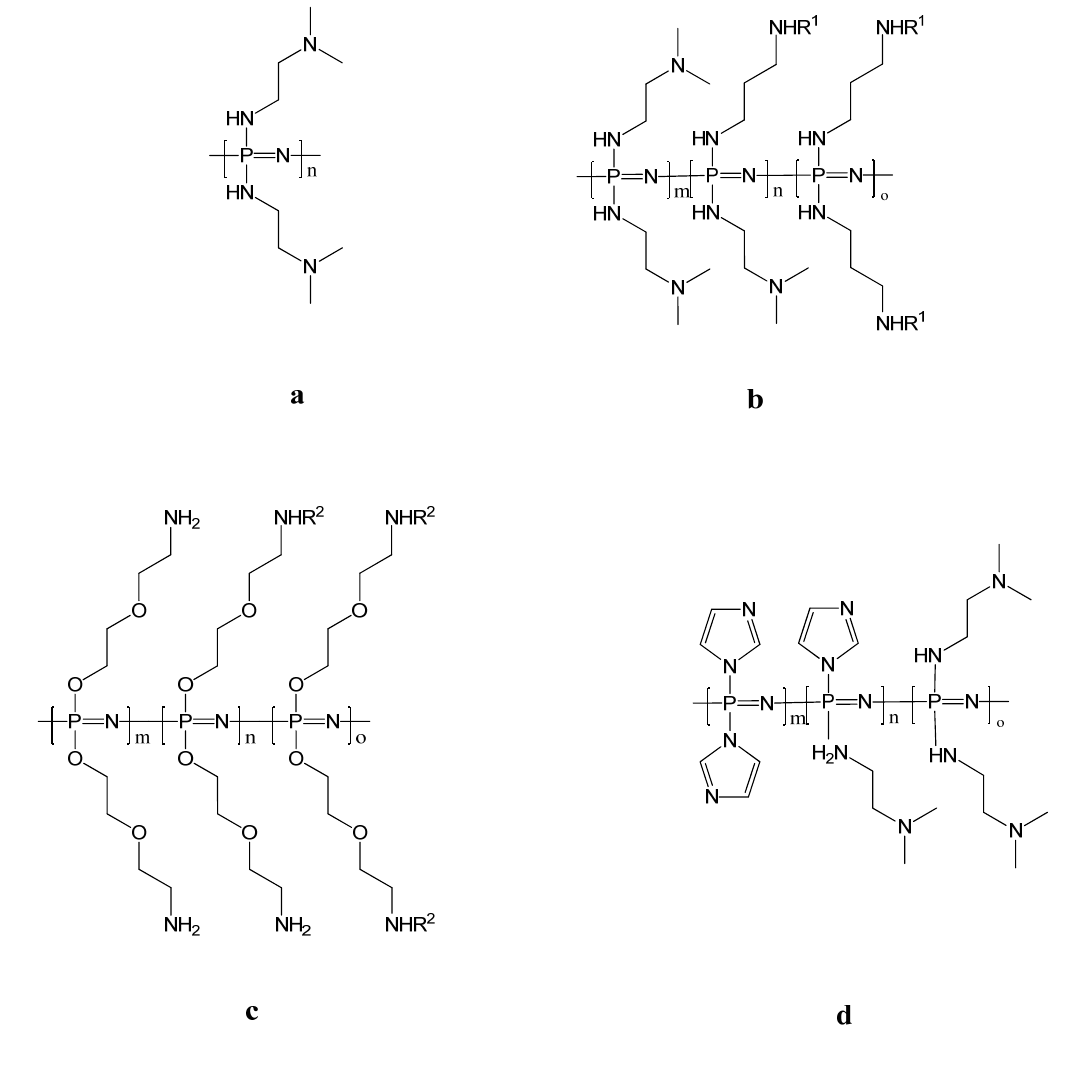
Figure 14. Structures of cationic polyphosphazenes tested for gene delivery. R 1 and R 2 can be varied for the attachment of, for example, tumor targeting ligands or pegylating